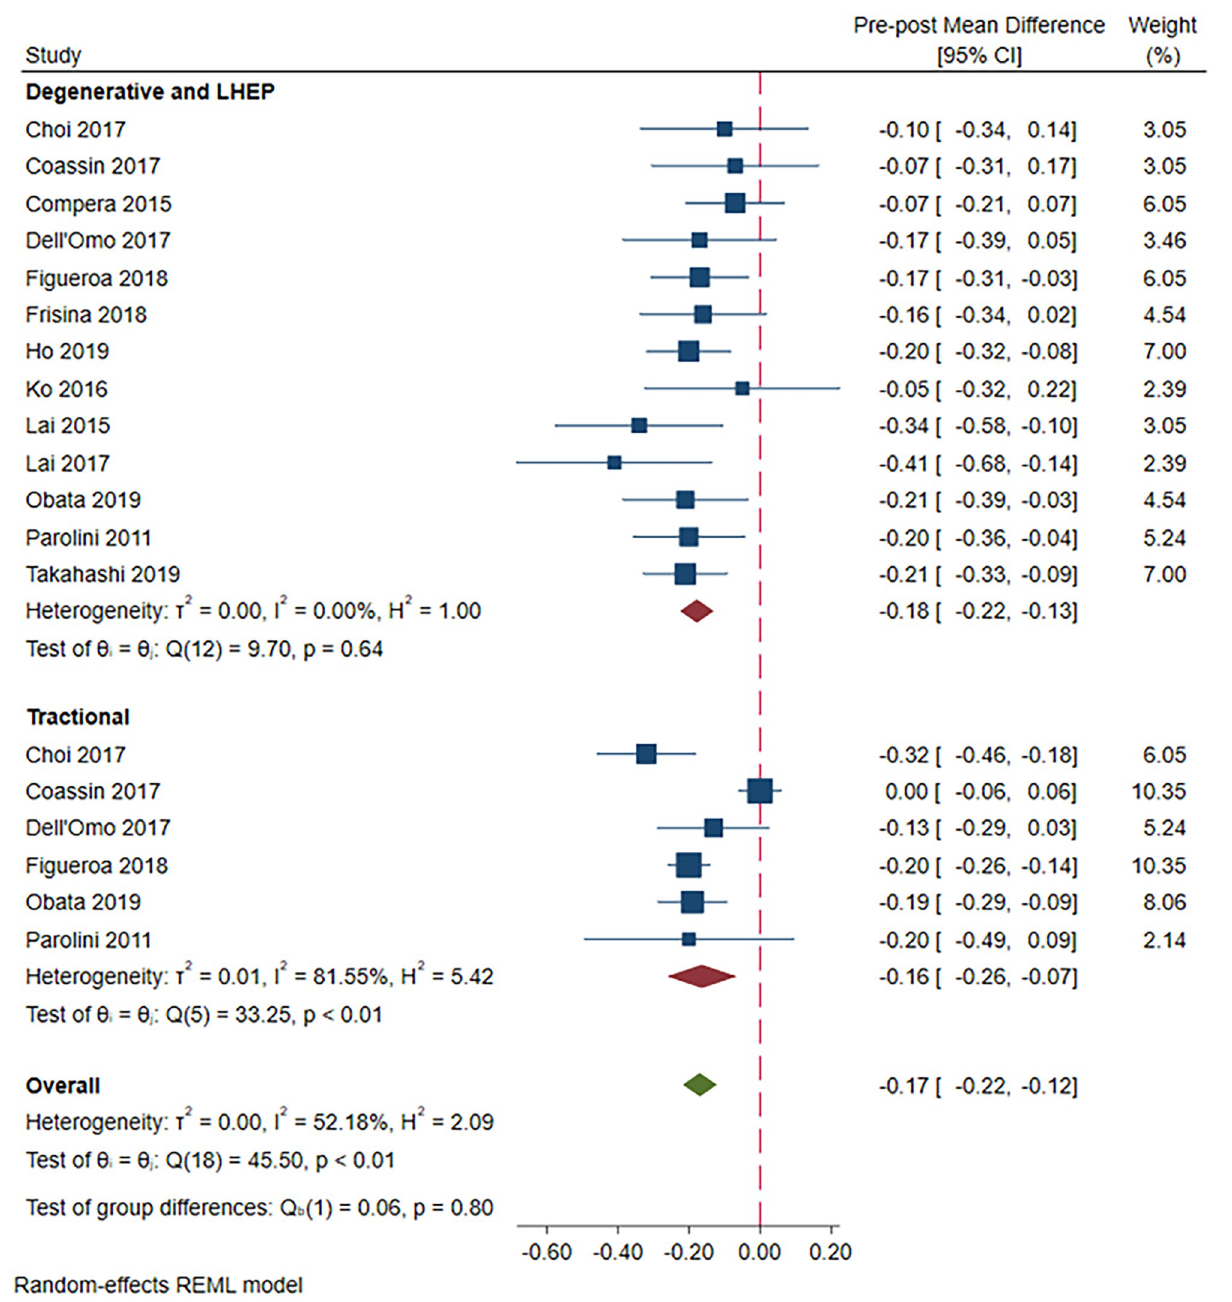
Fig 2. A forest plot showing pre-post mean difference in BCVA in the degenerative LMH and LHEP group versus the tractional LMH group.